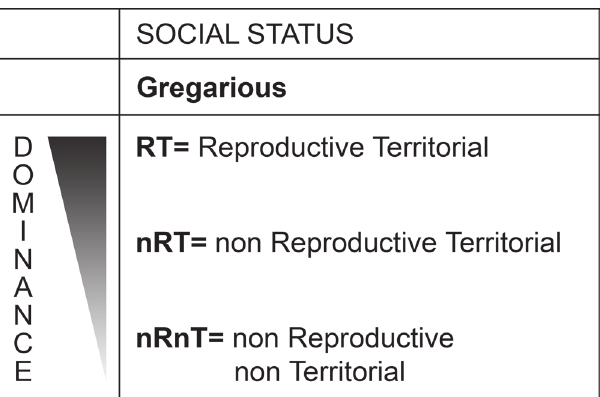
Table 2. Dominance and social statuses in Cichlasoma dimerus